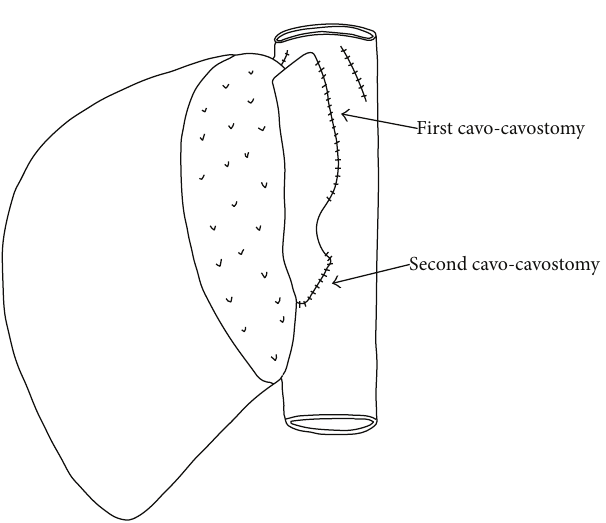
Figure 3: The second cavocaval